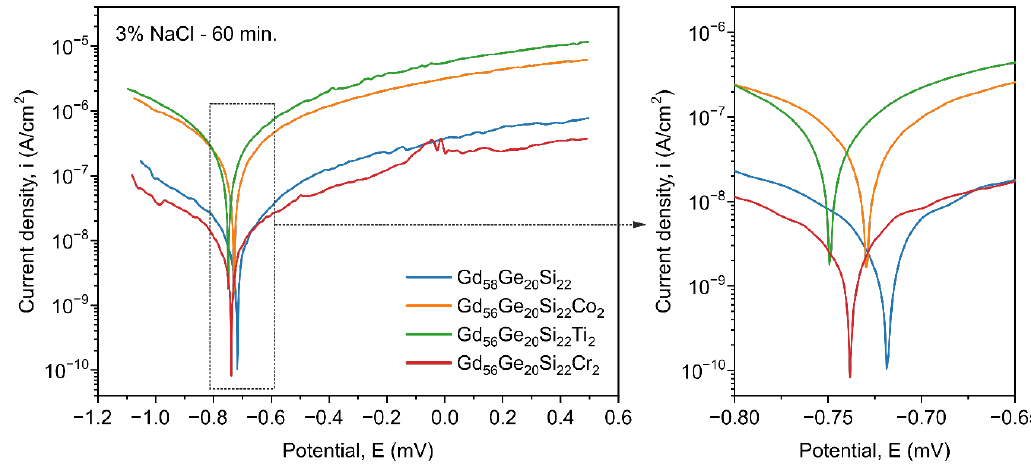
Figure 6. Polarisation curves determined in 3% NaCl solution for the Gd 58-x Ge 20 Si 22 Y x (x = 0 or 2; Y = Co, Ti or Cr) alloys after 60 min exposure.